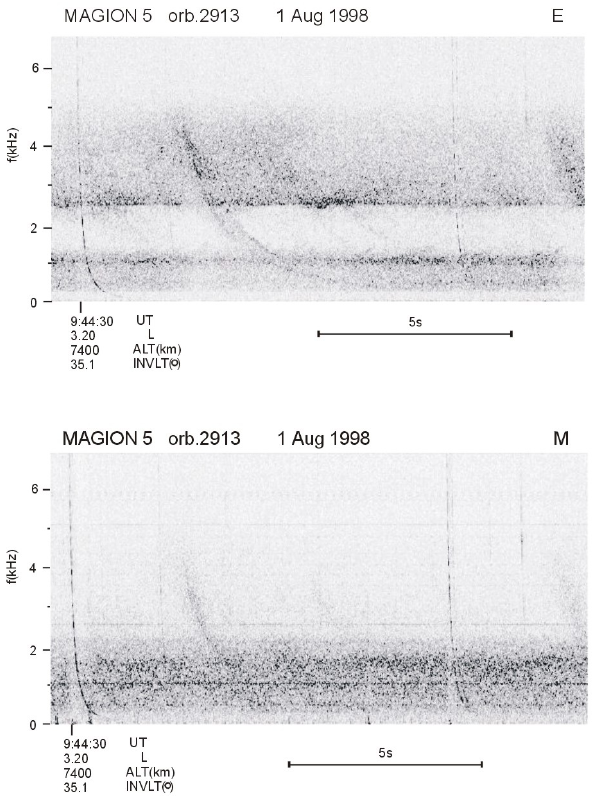
Fig. 5. Examples of LHR-noise recorded by the electric antenna in the plasmasphere.